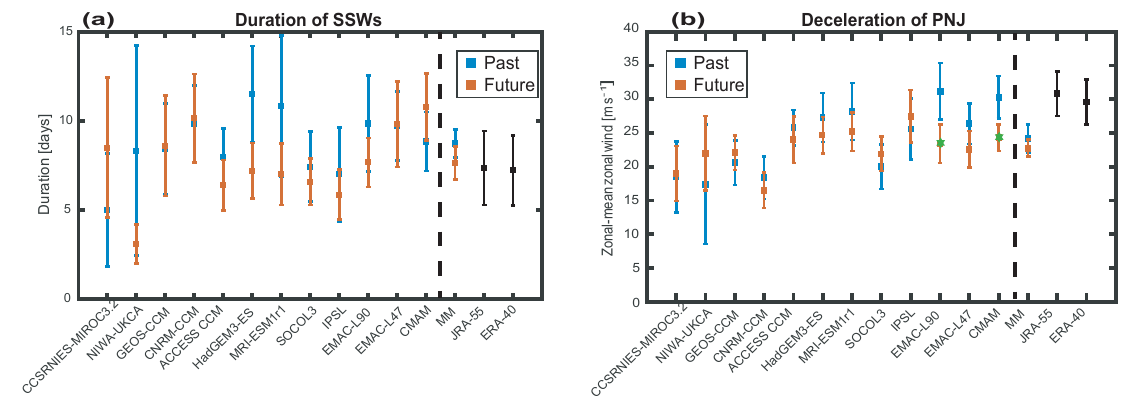
Figure 2. (a) Duration of SSWs (in days) and (b) deceleration of the PNJ associated with SSWs (in ms − 1 ) in each model for both periods of study. Bars denote ± 1 . 5 standard error, and green stars indicate future values that are statistically significantly different from the past ones at the 95% confidence